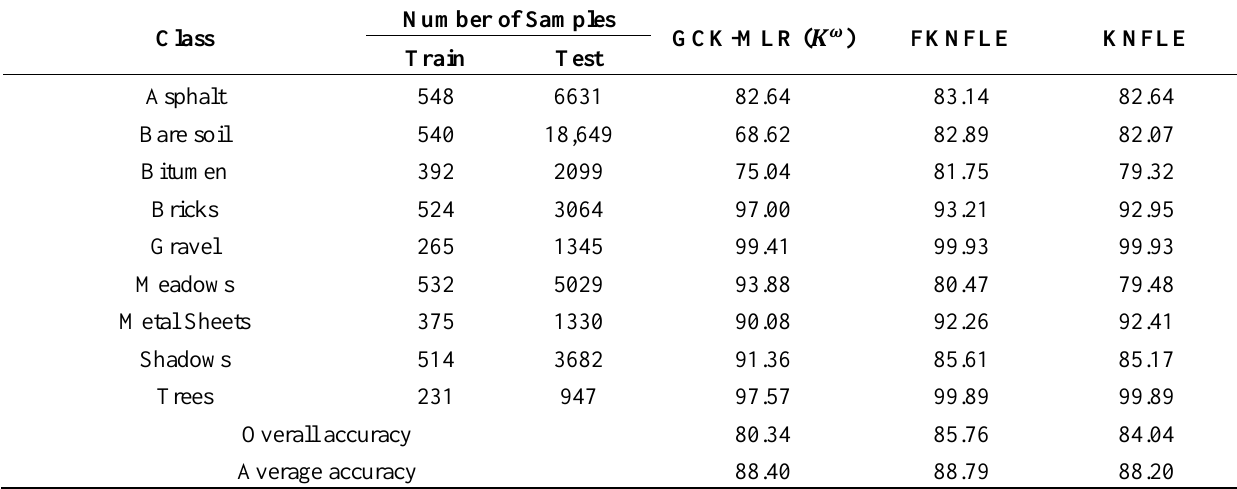
Table 9. The comparison between algorithm GCK-MLR ( 𝐾 𝜔 ) and the proposed method for dataset Pavia University of nine classes (in